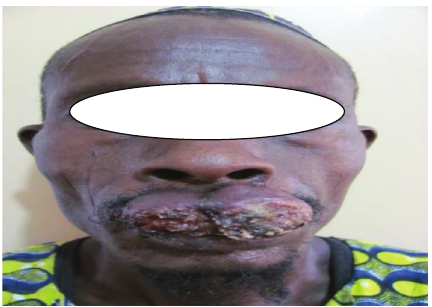
Figure 1: Extensive exophytic ulcer on the upper lip.